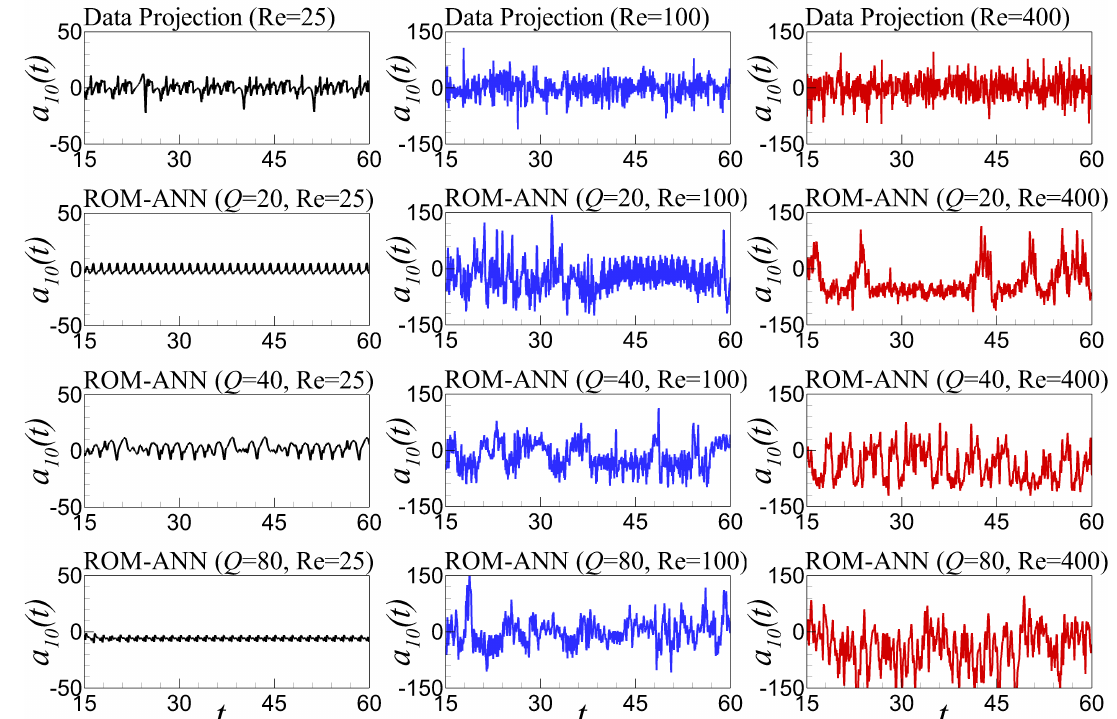
Figure 18. Sensitivity analysis with respect to the number of ELM neurons of fully non-intrusive ROM-ANN approach using time series of the tenth modal coefficient, a 10 ( t ) for Re = 25,100, 400 and Q =